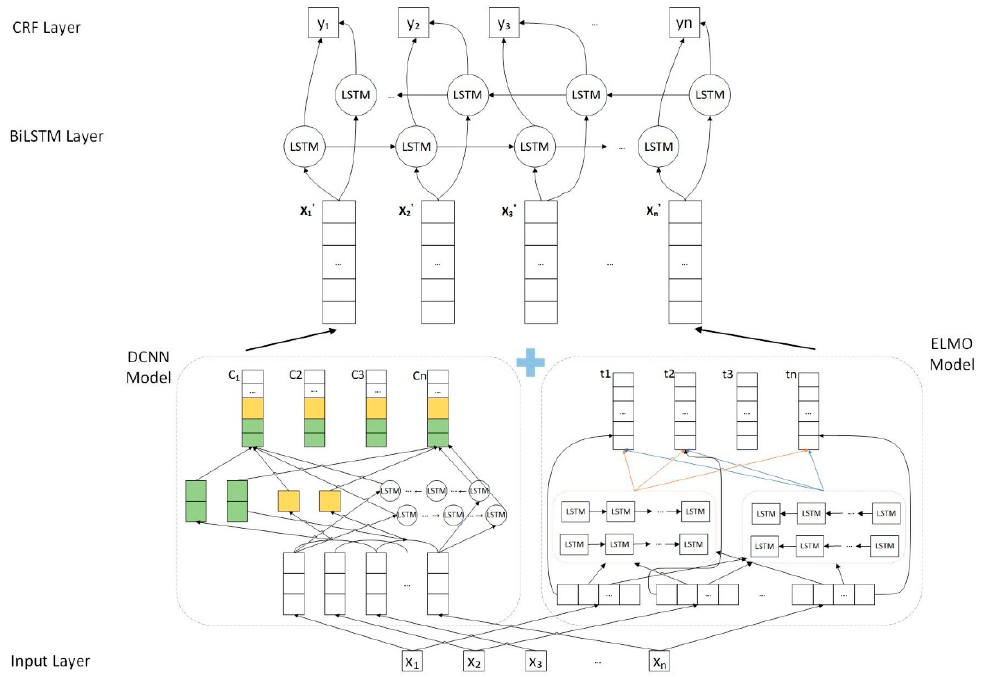
Figure 1. The overall structure of named entity recognition.